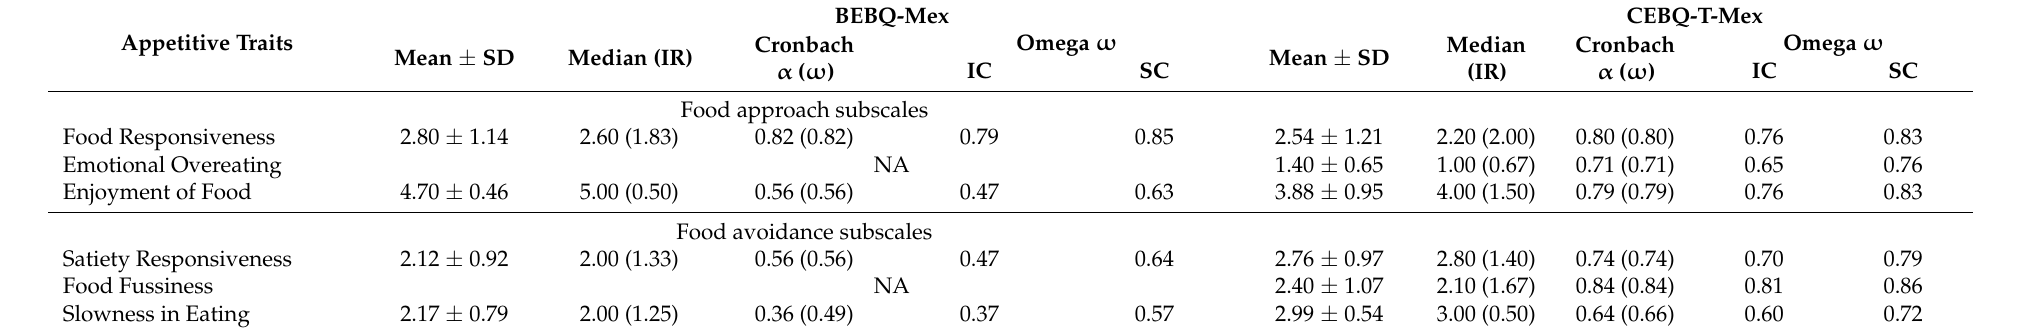
Table 2. Internal reliability (Cronbach’s alpha and omega) of the BEBQ-Mex (n = 330) and the CEBQ-T- Mex (n = 330). Appetitive Traits